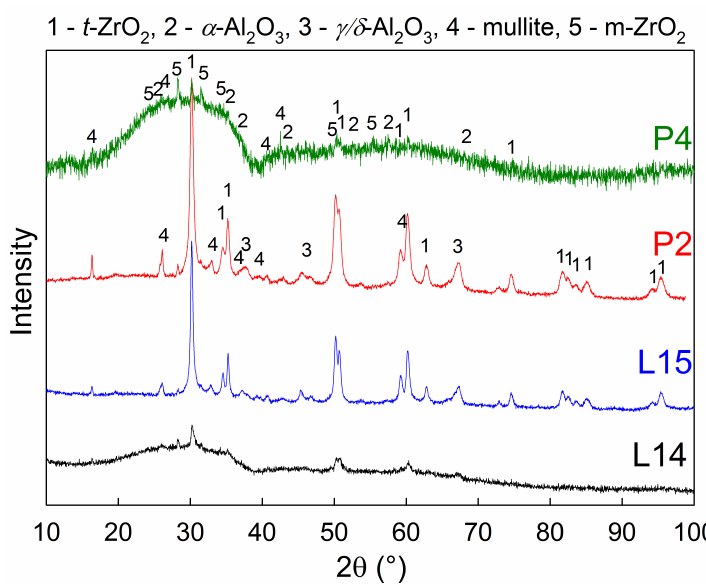
Figure 11. X-ray diffraction patterns of the laser and plasma heat treated samples. Figure 11. X-ray di ff raction patterns of the laser and plasma heat treated